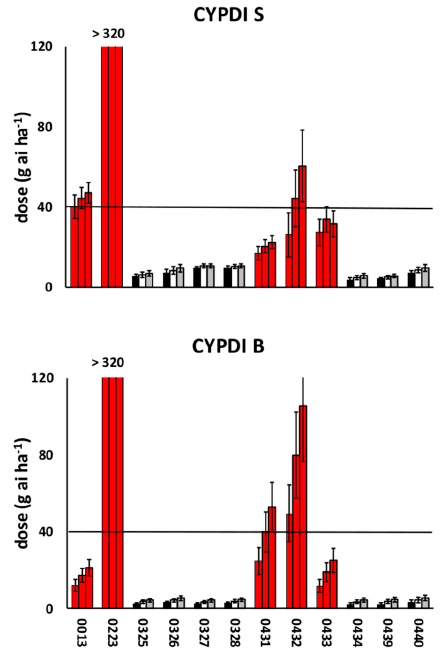
Figure 5. Estimation of ED 50 , ED 80, and ED 90 (ED 50 and GR 50 black bars, ED 80 , and GR 80 white bars and ED 90 and GR 90 grey bars) of penoxsulam for plant survival (S) and fresh biomass reduction (B) of populations of Cyperus difformis (CYPDI). Red bars indicate populations resistant to sulfonylureas (SUs) according to the preliminary screenings. Populations 0013 and 0223 are ALS-resistant checks. Vertical bars represent 95% Confidence Intervals. Recommended field dose of penoxsulam (40 g ai ha − 1 ) is represented by the horizontal black line.